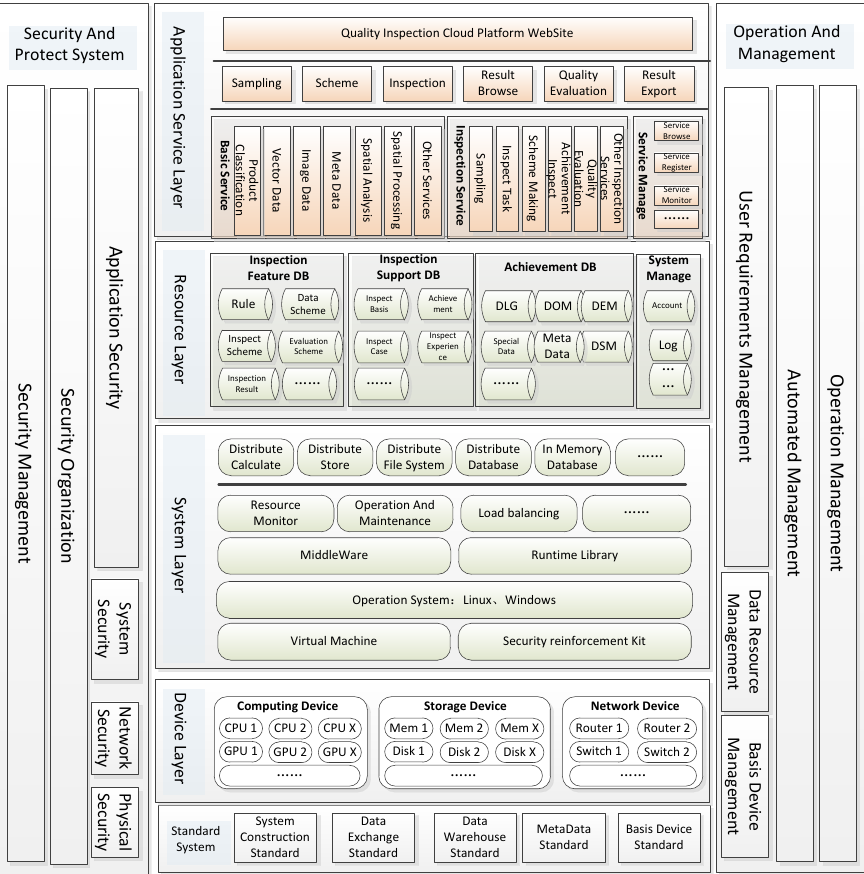
Figure 5 Quality Inspection Cloud Platform